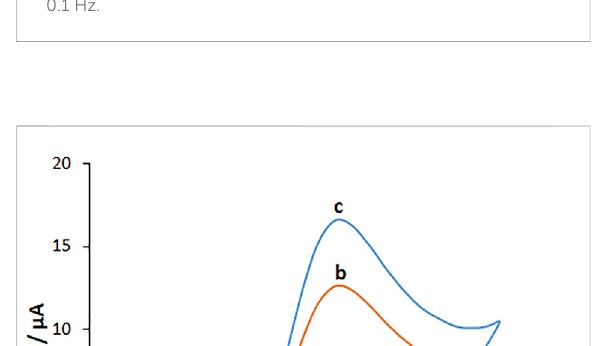
FIGURE 5 (A) CVs of MWCNT/HG-NiO-ND/PGE in the presence of 0.2 mM [Fe(CN) 6 ] 3- solution in aqueous 0.1 M KCl at various scan rates(frominnertooutercurves):10,20,30,40,50,60,70,80,90, 100, 200, 300, 400, and 500 mV/s. (B) Plot of peak currents vs. υ 1/2 .